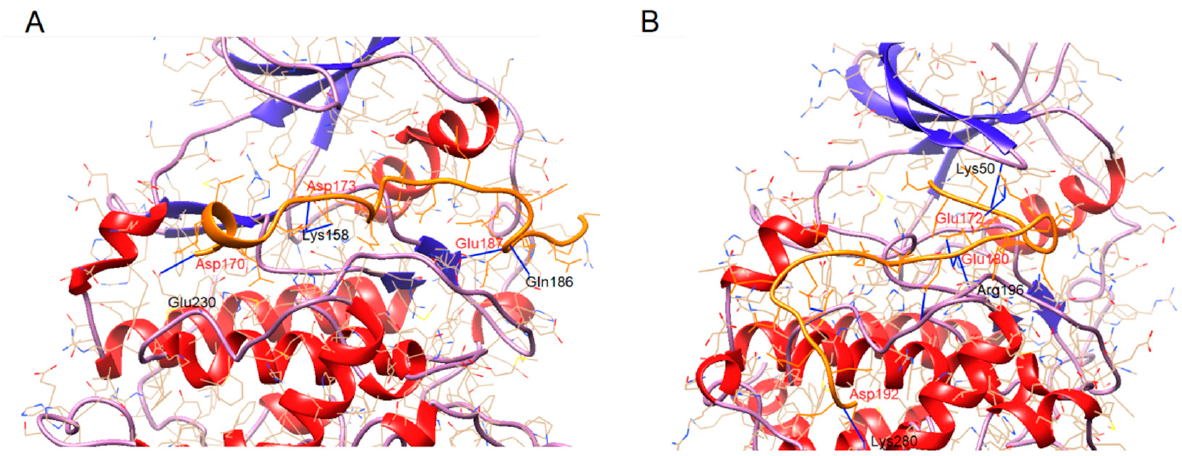
Figure 7. CABS-dock model of the binding modes. ( A ) CK2 α (1PJK) and Asf1 170-193 , ( B ) CK2 α΄ (3OFM) and Asf1 170-193 . The peptide is shown in orange. Amino acids involved in the binding are given in black (enzyme) and red (peptide). Table 1. List of hydrogen bonds formed between CK2 catalytic subunits and Asf1 170-193 .